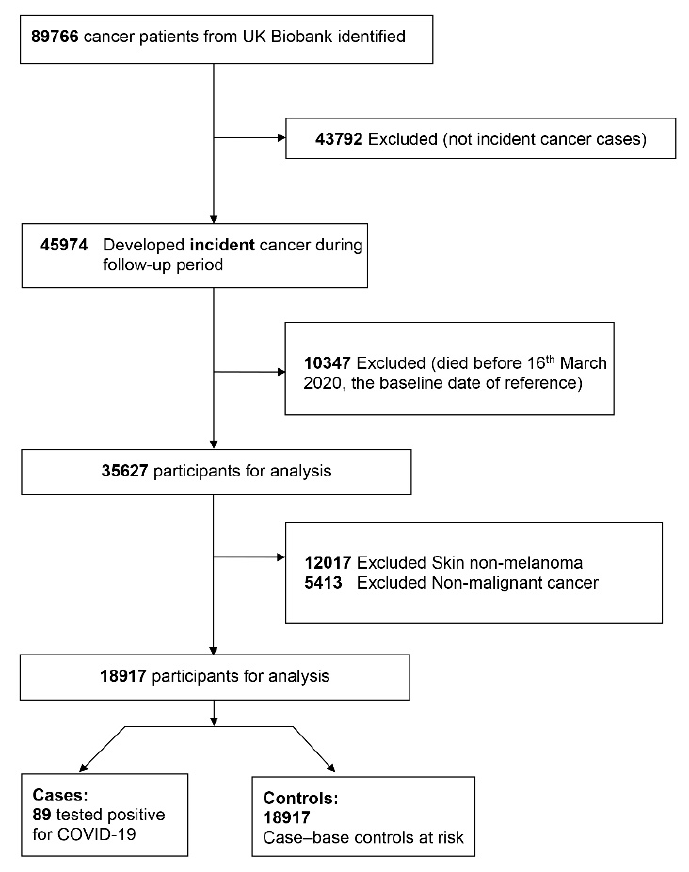
Figure 1. Case-cohort UK Biobank Study flowchart.